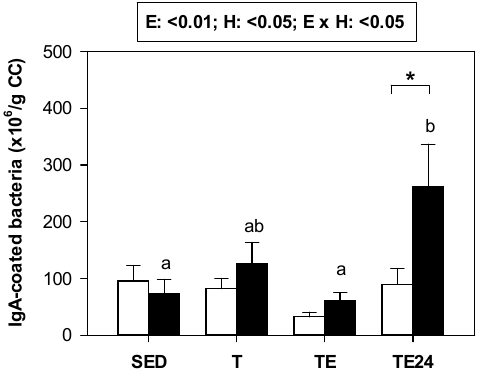
Figure 3. Number of cecal bacteria coated to IgA ( × 10 6 /g cecal content). The non-supplemented groups are represented by white bars and the hesperidin-supplemented groups by black bars. CC = cecal content; SED = sedentary groups; T = trained groups; TE = T groups with an additional exhaustion test; TE24 = TE groups 24 h after the exhaustion test. E = exercise; H: hesperidin supplementation; E × H = interaction between E and H. Data are expressed as mean ± SEM ( n = 8). As E × H interaction was significant, Tukey’s post hoc test was carried out, and changes between particular groups are represented with different letters above those groups that showed different results, and changes due to hesperidin supplementation are represented with an asterisk.